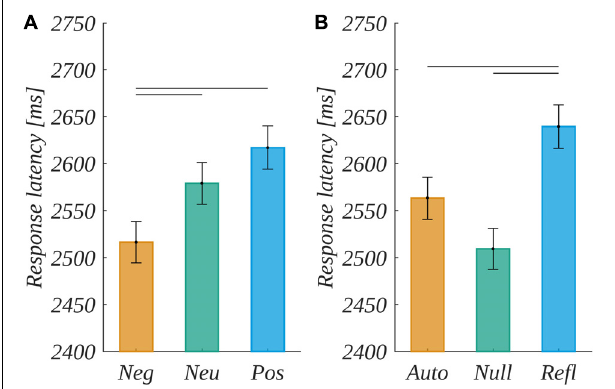
FIGURE 6 | Response latencies for valence (A) , and origin (B) levels. The bars and SEM are in linear scale, the statistical differences marked by horizontal lines were computed for logarithms of